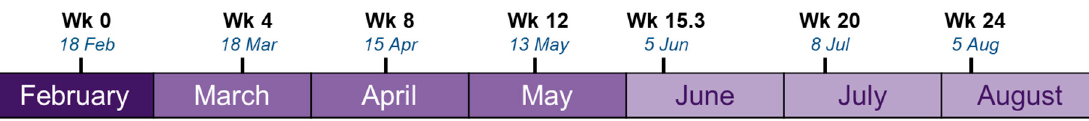
Figure 4. Rack containing the coupons at ( a ) 36° tilt angle and ( b ) 0° tilt angle.